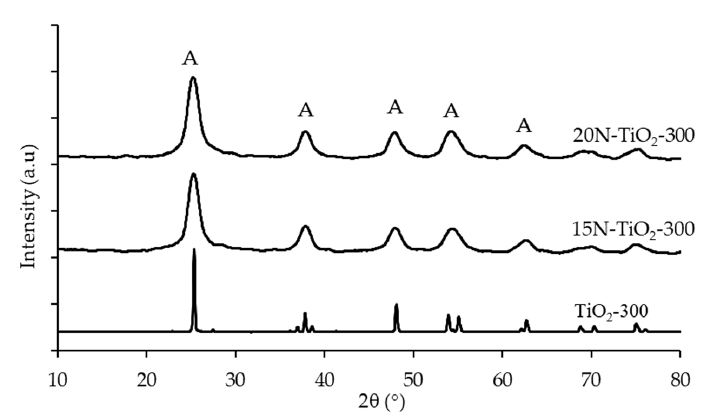
Figure 3. X-ray diffraction (XRD) pattern of anatase TiO 2 and N–TiO 2 photocatalysts calcined at 300 °C (A = Anatase phase).